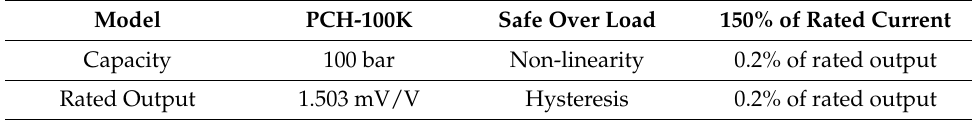
Table 2. Pressure transducer specifications.